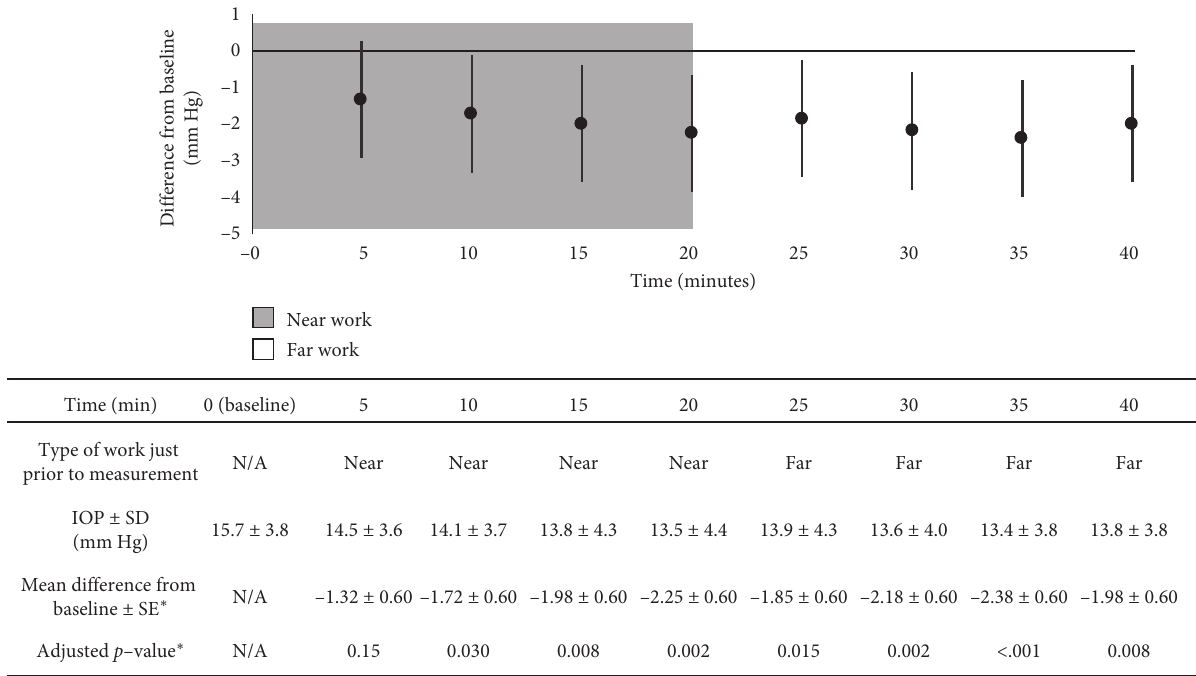
Figure 2: Graphed statistical results with raw data in table (statistically significant differences exist when the graphed 95% confidence interval does not contain zero, which corresponds to p values less than 0.05 (bold); asterisk indicates results derived from the repeated measures